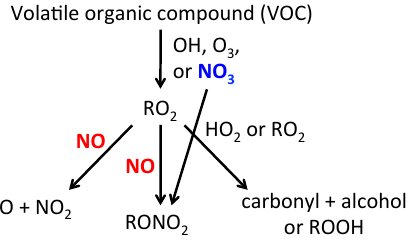
Fig. 1. Overview of potential NO x effects on the oxidation of a volatile organic